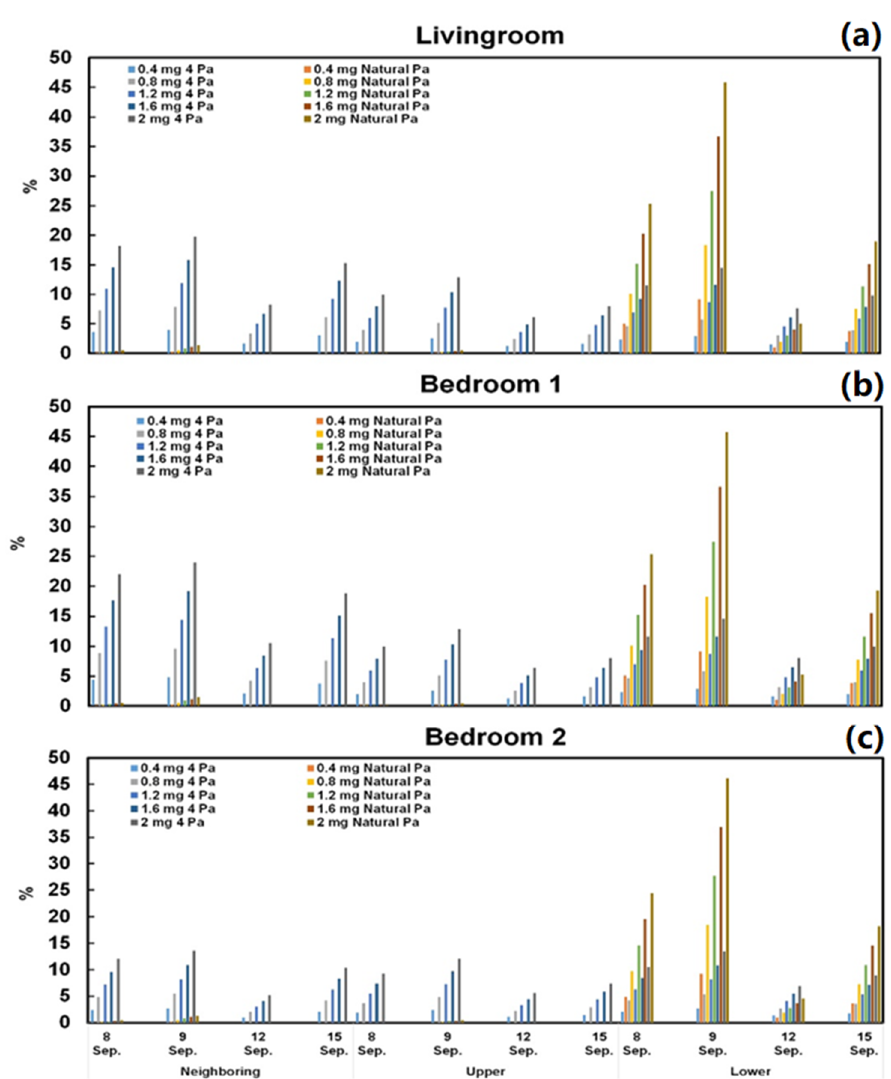
Figure 8. The percentage increase of PM 2.5 concentration in living room ( a ), bedroom 1 ( b ) and bedroom 2 ( c ) in four days (8, 9, 12, and 15 September) with five generation rates (0.4; 0.8; 1.2; 1.6; 2 mg min −1 ) on the three floors (neighboring, upper, and lower apartments) based on two condi- tions.